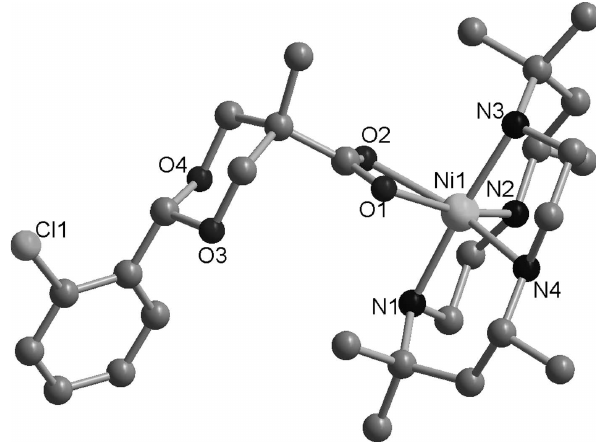
Table 2: Fractional atomic coordinates and isotropic or equivalent isotropic displacement parameters (Å 2